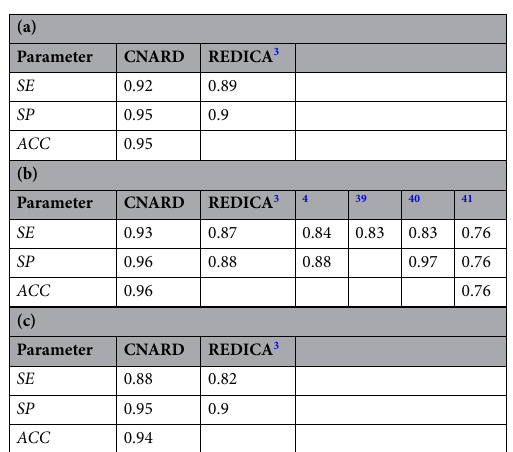
Table 2. Sensitivity, specificity and accuracy values for CNARD method, REDICA 3 , the methods of 4,39–41